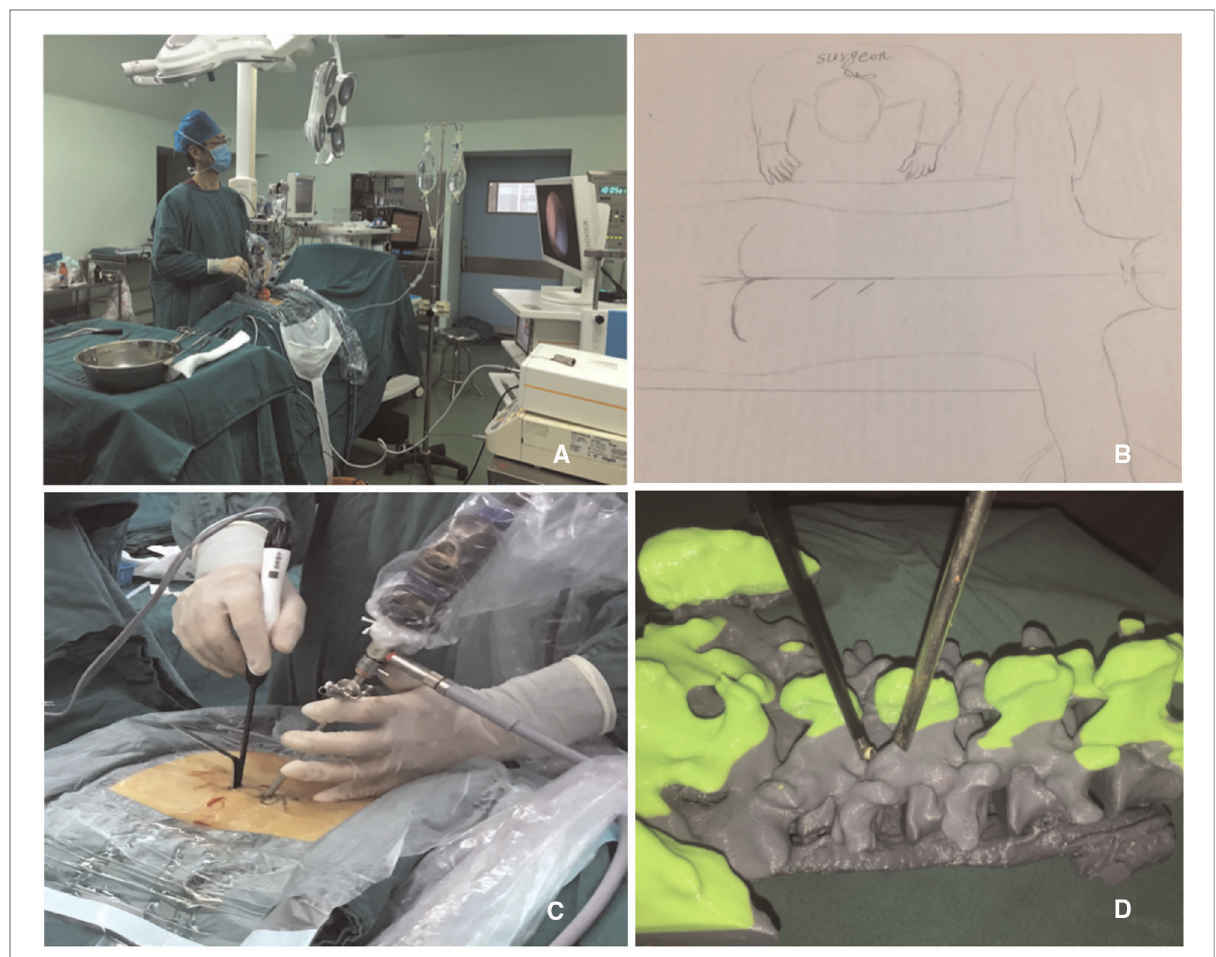
FIGURE 2 Surgeon ’ s operative position and schematic illustration of operative setup. ( A ) If the patient has a right side lesion, the operating surgeon stands on the left side and the procedure is performed on the right (lesion) side via inclinatory operative trajectory (position for a right-handed surgeon); ( B ) schematic illustration of the operation setup; ( C ) intraoperative views of contralateral Inclinatory approach to the lesion side over the midline of spinous process and the angle of scope and instruments; and ( D ) inclinatory operative trajectory is simulated on the arti fi cial lumbar spine